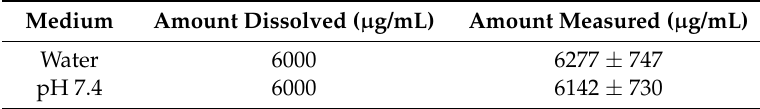
Values are given as mean ± standard deviation of triplicate